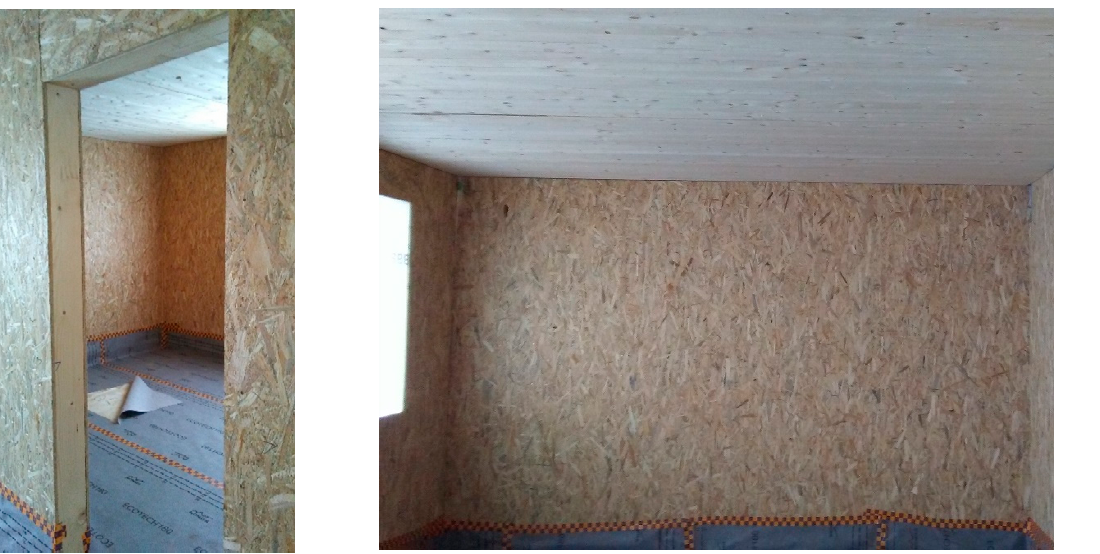
Figure 2. Pictures of the internal partition.